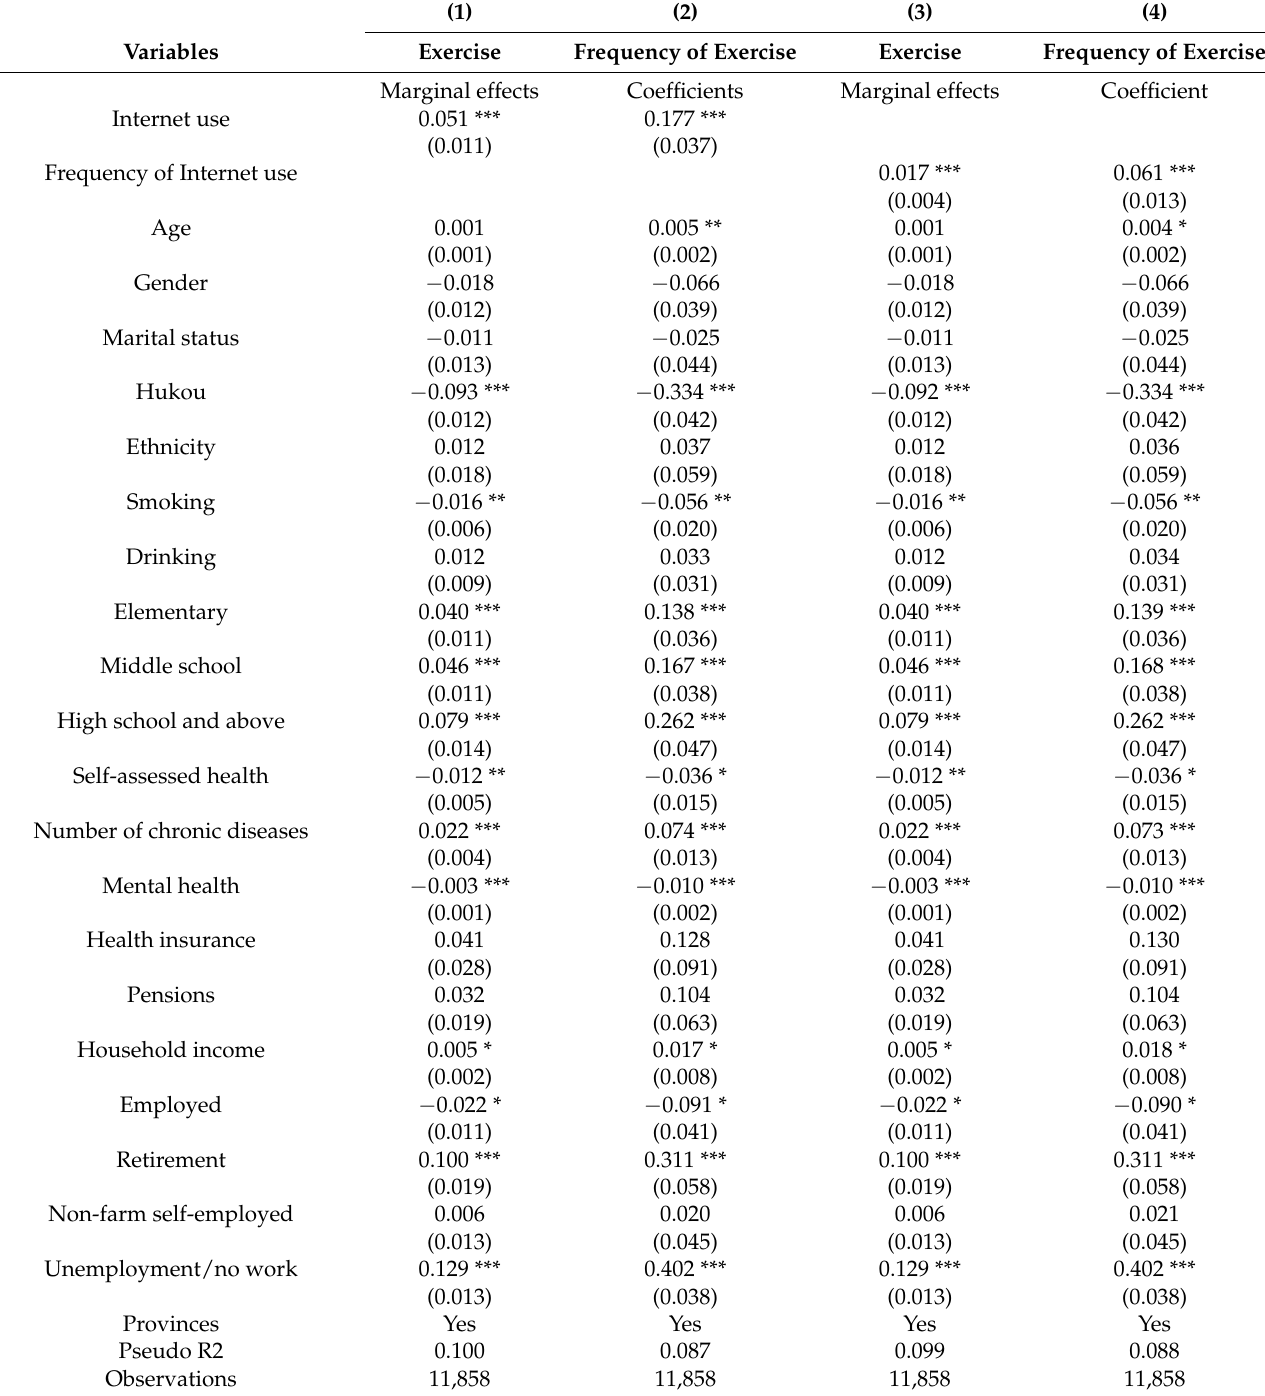
Table 2. Regression results of the association between Internet use and physical